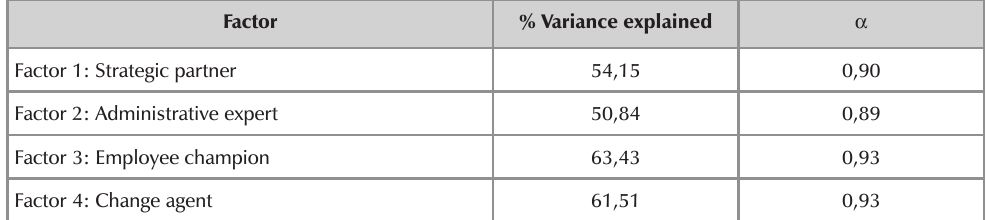
Confirmatory factor analysis of the Human Resource Role-Assessment